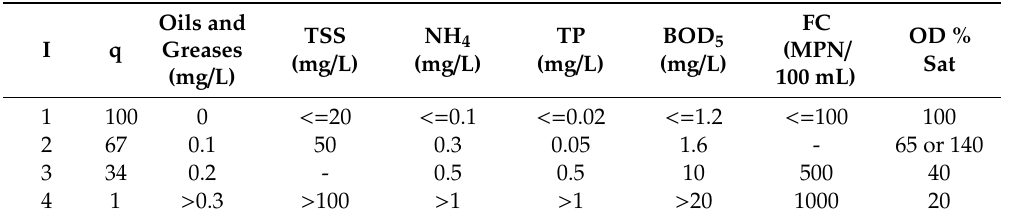
Table A6. Sub-index values